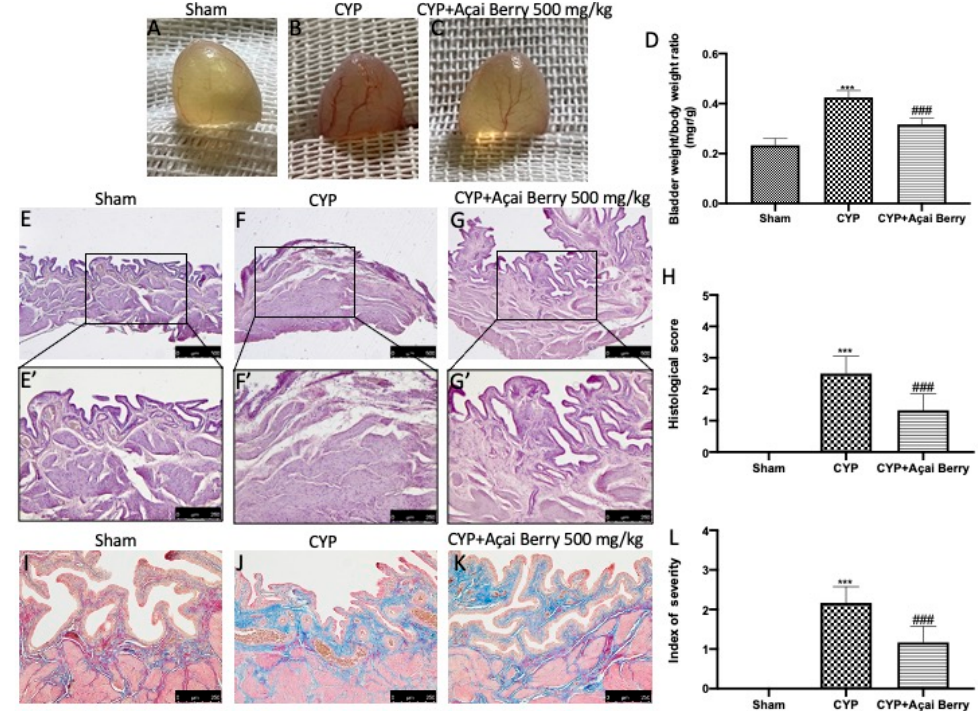
Figure 1. Impact of açai berry on CYP-induced bladder alteration. Macroscopic bladder in ( A ) sham, ( B ) CYP, and ( C ) açai berry treatments. ( D ) Bladder weight. Histological evaluation of bladder stained with H/E in ( E , E (cid:48) ) sham, ( F , F (cid:48) ) CYP, and ( G , G (cid:48) ) açai berry treatments. ( H ) Histological score. Masson’s trichrome of ( I ) sham, ( J ) CYP, and ( K ) açai berry treatments. ( L ) Index of severity. *** p < 0.001 vs. sham; ### p < 0.001 vs.